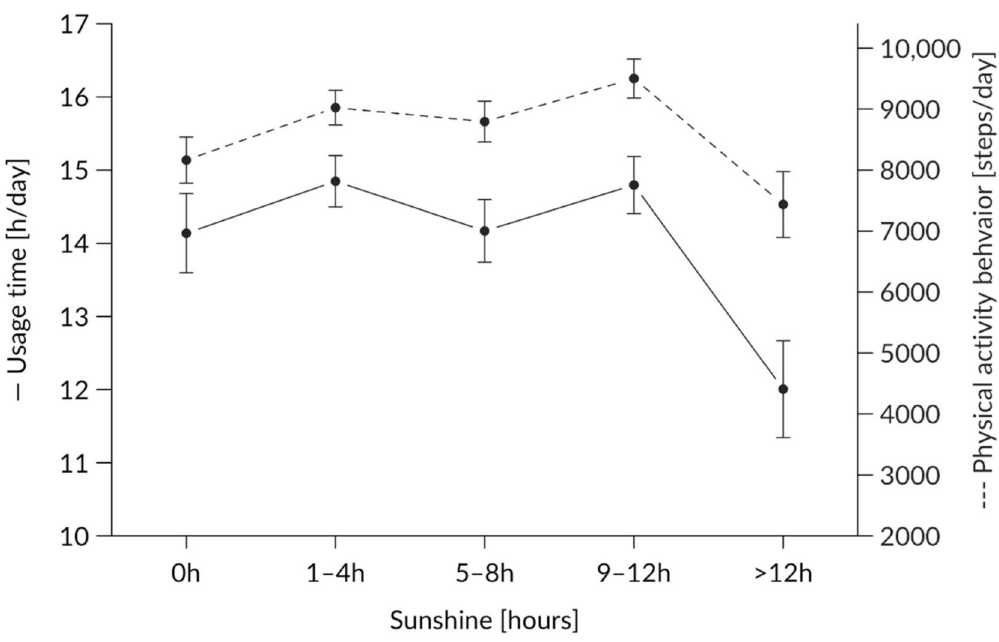
Figure 5. Average use per hour of sunshine depicted for usage time (h / day) on the y-axis on the left-hand side and physical activity behavior (steps / day) on the y-axis on the right-hand